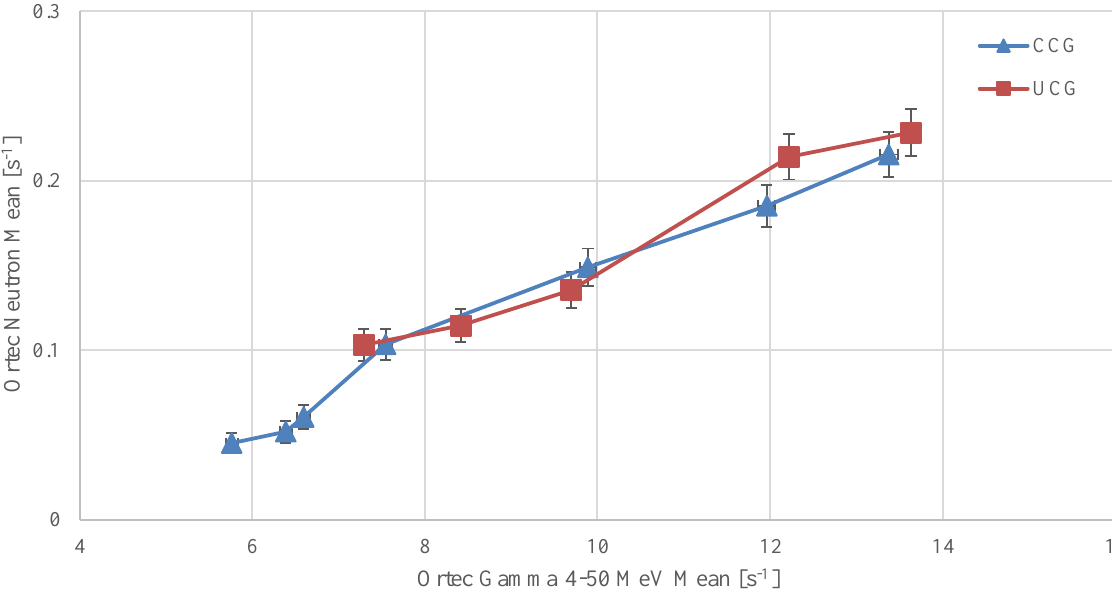
Figure 8. The mean Ortec neutron count rate as a function of the mean Ortec NaI count rate (between 4 MeV and 50 MeV) at each location in the Central Campus and University Center Garages (CCG and UCG). The data were collected continuously over 15-20 minutes and had a five second rolling average applied before calculating the mean. 1-σ error bars are shown, but some of them may be obscured by the data